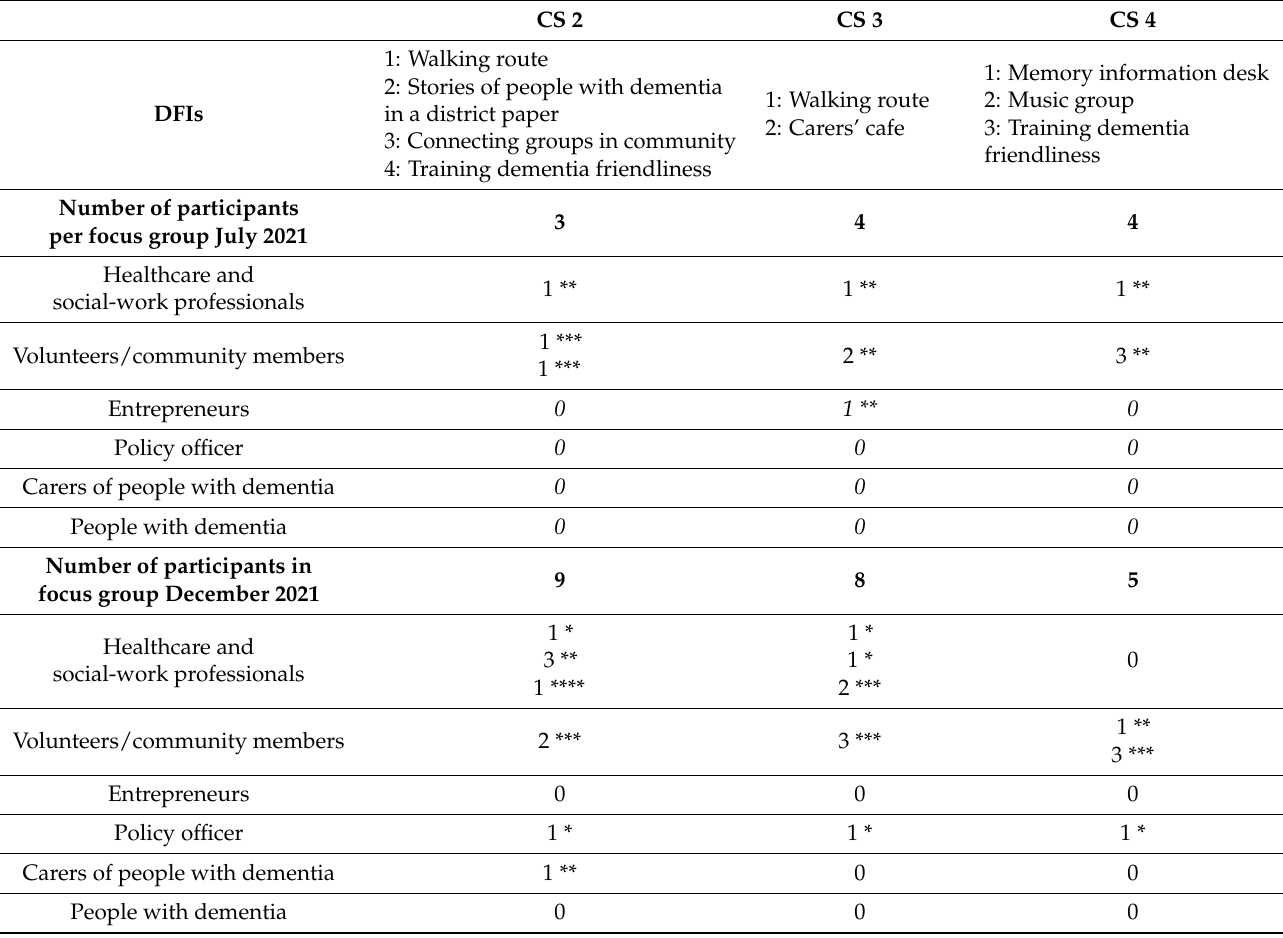
Table 2. Presentation of the DFIs that were developed or sustained in each case, and the participants during data